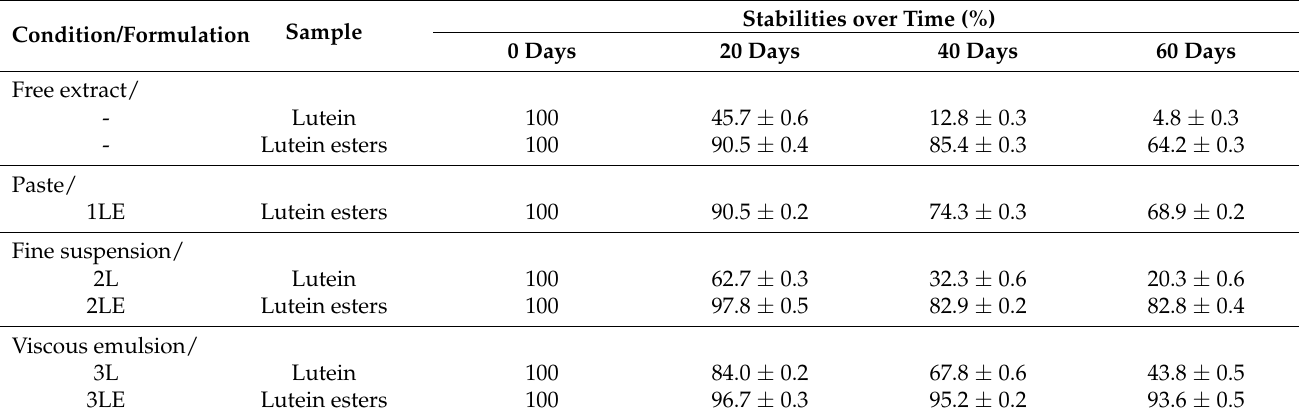
Table 3. Stabilities of the formulations with lutein/lutein esters during storage at 25 ◦ C in the dark.